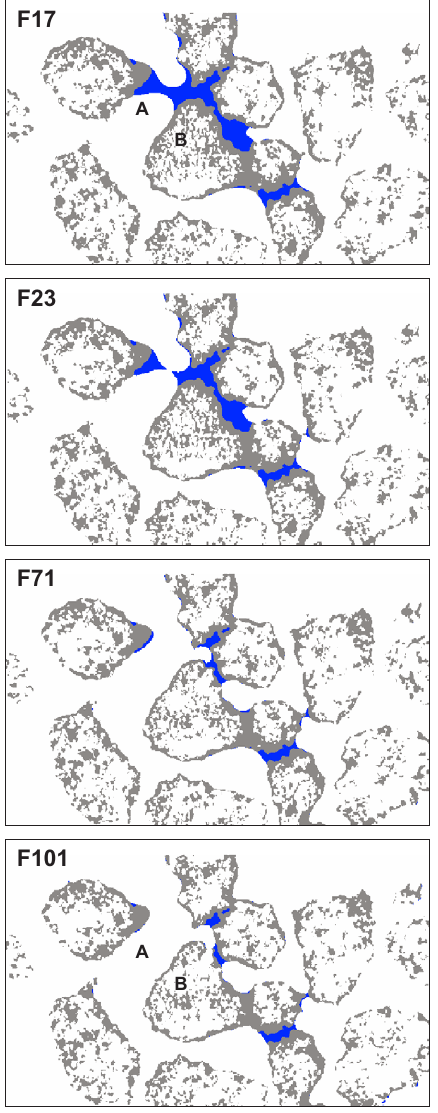
Figure 4. A single vertical 2-D slice through the second frame. The frames shown cover the passage of the through the sample. The inter-grain fluid is shown in blue and the intra-grain fluid in grey. Wet rocks are grey; KI solution outside the rocks is blue; air and dry rocks are in the background. Field of view is 3.5mm × 2mm. Data are from sample LH_9, scan 3.